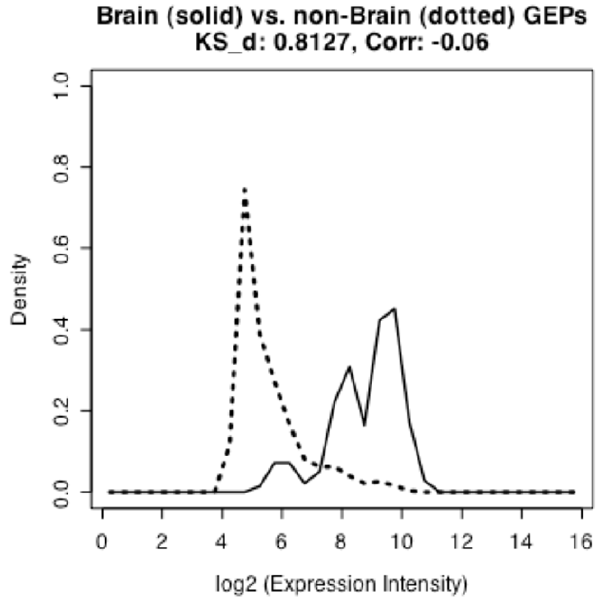
Figure 3. A selected representative example comparing the GEPs of Grla3 in brain (solid line) and non-brain (dashed line) tissues.